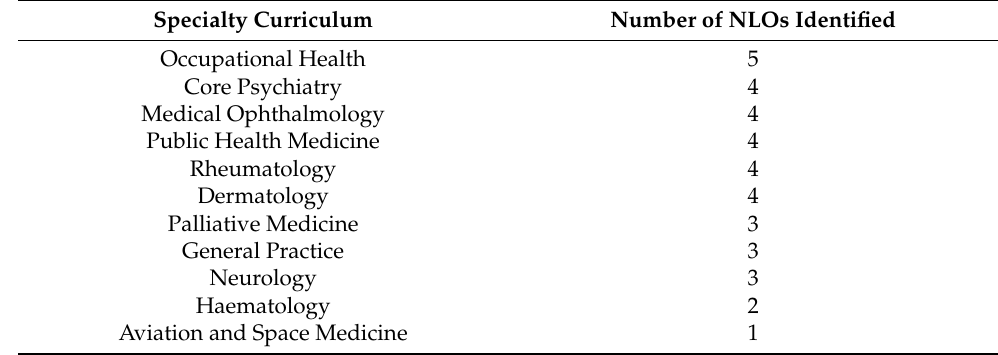
Table 2. Specialty curriculums in the bottom quartile, with five or less nutrition-related learning objectives (NLOs) (descending